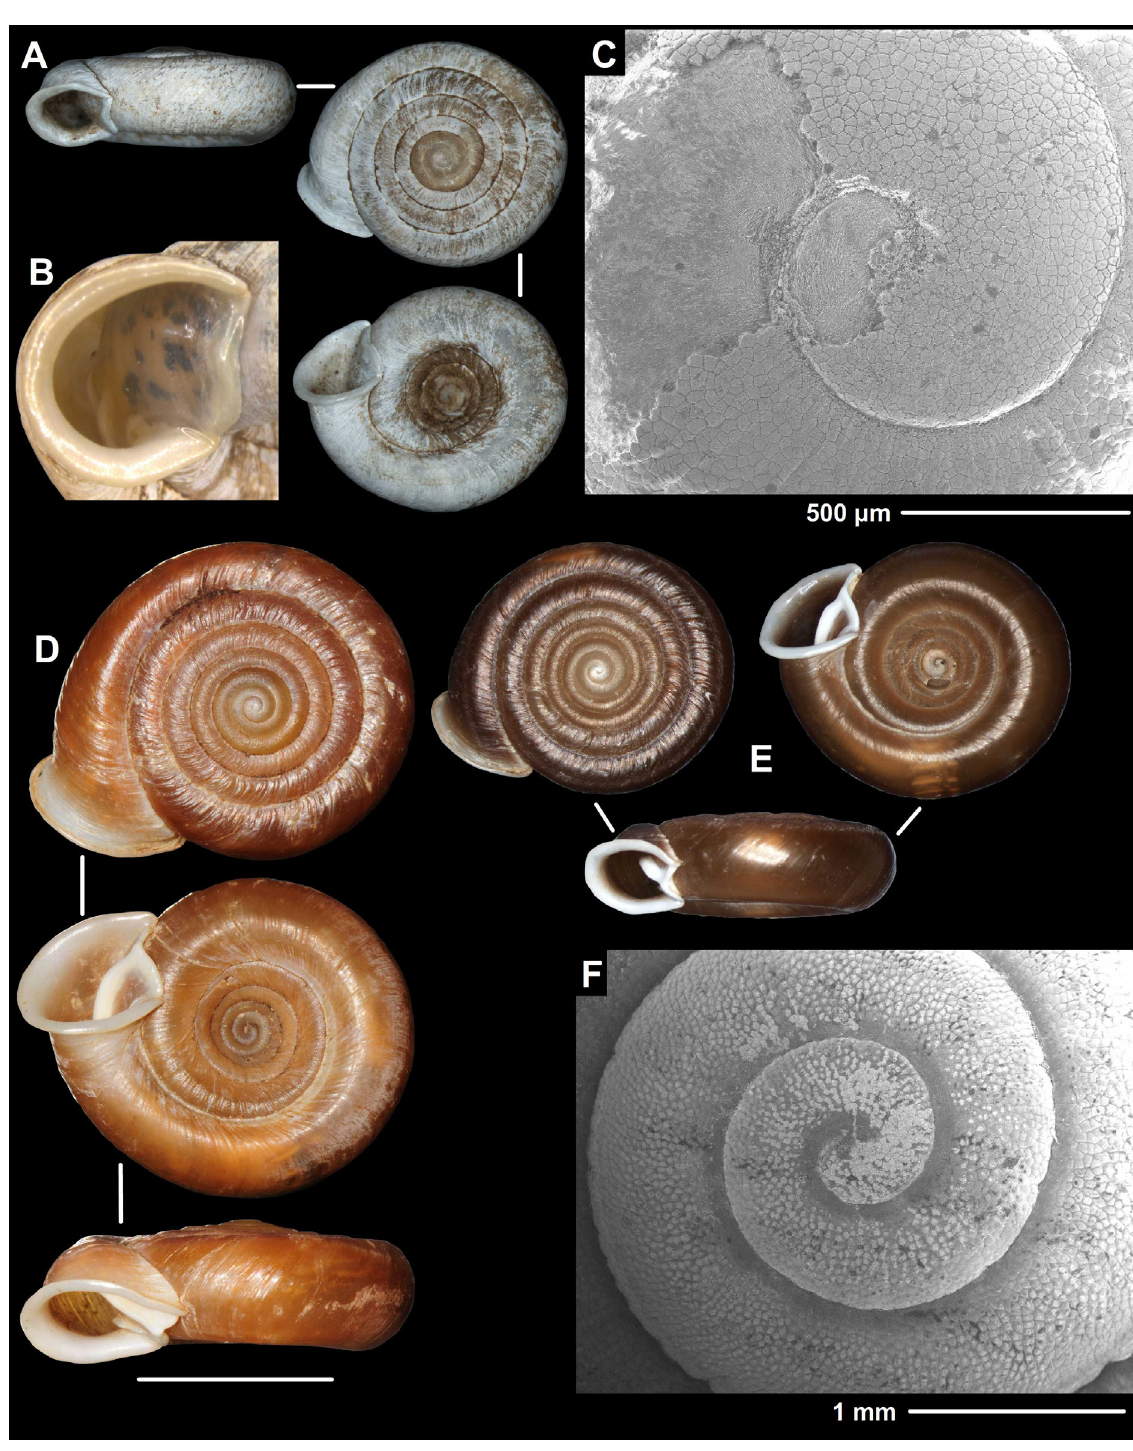
Fig. 26. Shells of species of Chersaecia Gude, 1899. A . C. scabra sp. nov., holotype (UF 380244). B . Aperture of C. scabra sp. nov., paratype (NHMUK 20170149). C . Protoconch of C. scabra sp. nov (UF 380244). D . C. shanensis (Stoliczka, 1873) (NHMUK 20170293). E . C. shanensis (NHMUK 20170292). F . Protoconch of C. shanensis , loc. 20091018B (coll. PGB). Scale bar (bottom left): A, D–E = 10 mm; B not to scale. Images: T. Deli (A, D–E), B. Páll-Gergely (B–C,